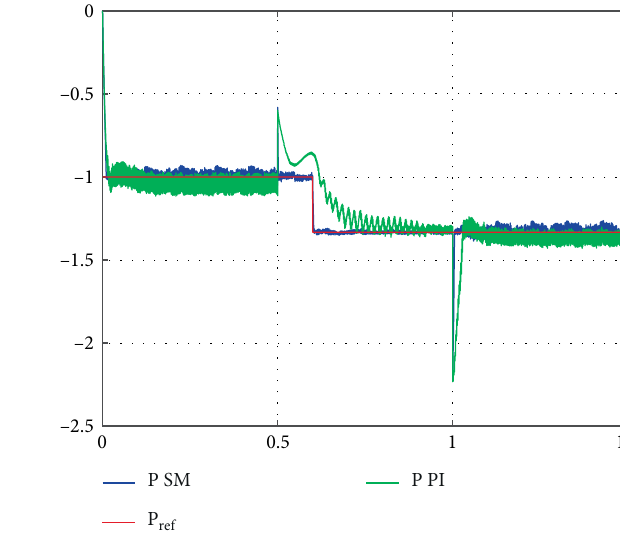
Figure 17: Active power with 40% depth of stator